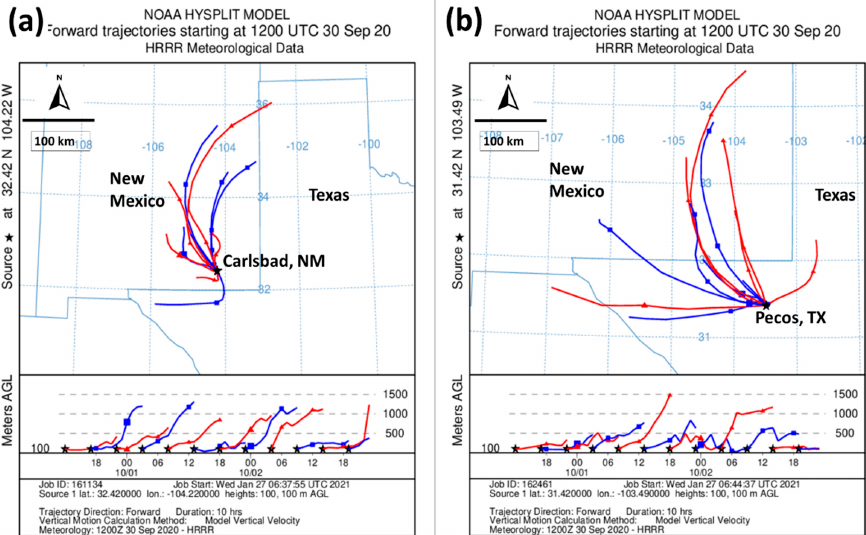
Figure 9. NOAA HYSPLITT model trajectories initialized every 5 h between 1200 UTC 30 September 2020 and 0000 UTC 3 October 2020 at: ( a ) Carlsbad, New Mexico; and ( b ) Pecos, Texas. The HRRR model was used to drive the trajectory simulations. Particles were initialized at a height of 100 m above ground level (AGL). The hypothesis of transport of CH 4 from the ONG production regions toward the northwest in the absence of strong westerly flow appears to be supported by the quiescent case study analysis, trajectory simulations, and climatological surface wind analyses pre- sented. Figure 10 illustrates graphically the various flows (upvalley and upslope), in ad- dition to other factors such as strength of westerly winds and atmospheric stability that impact the spatial and temporal variability of the Permian Basin methane column en- hancements.